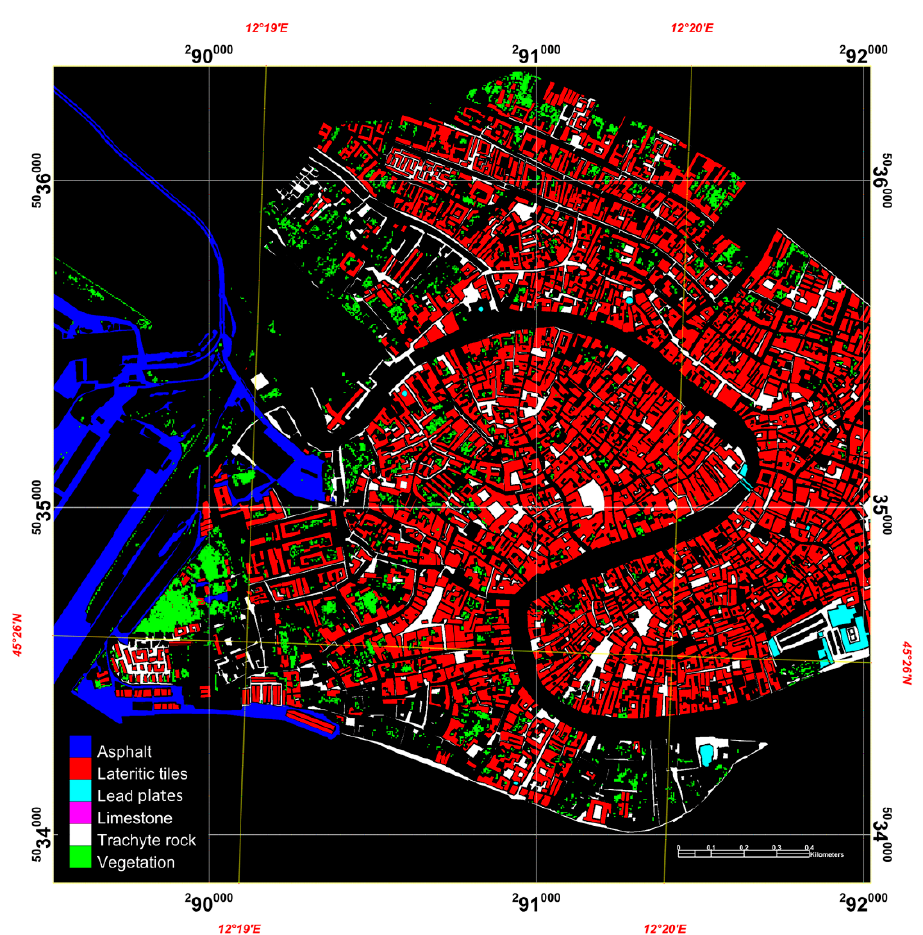
Figure 4. Reference maps that was validated with additional ground truth data [48,49].